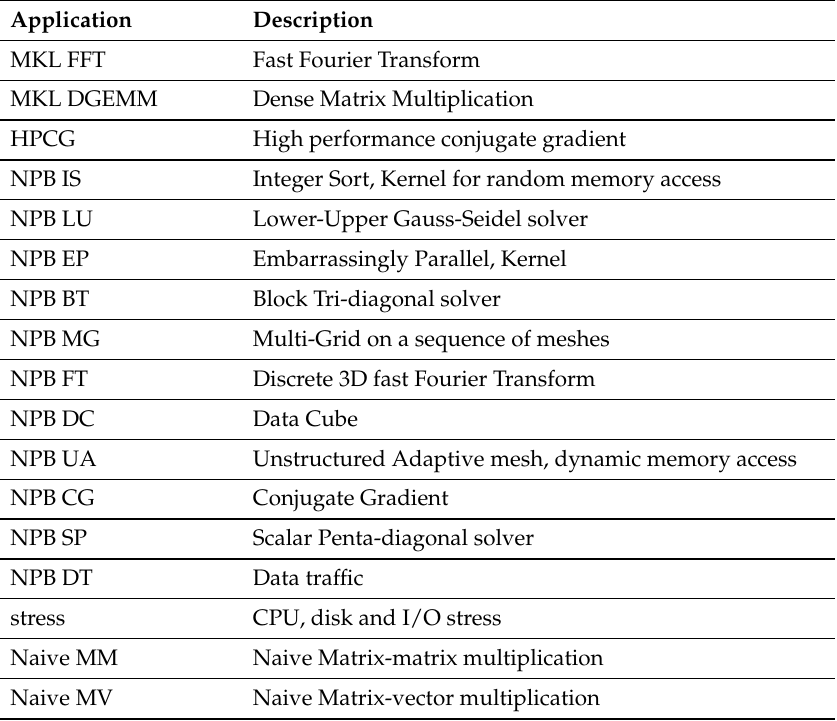
Table A6. List of